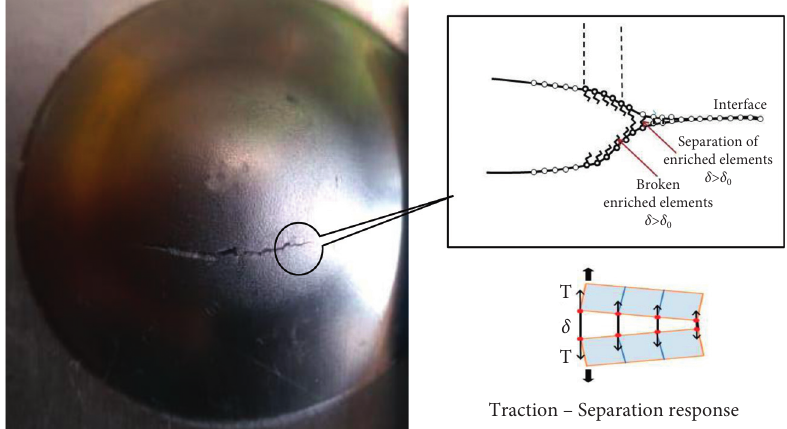
Figure 5: CP-Ti material to illustrate the traction-separation during mechanical loading.